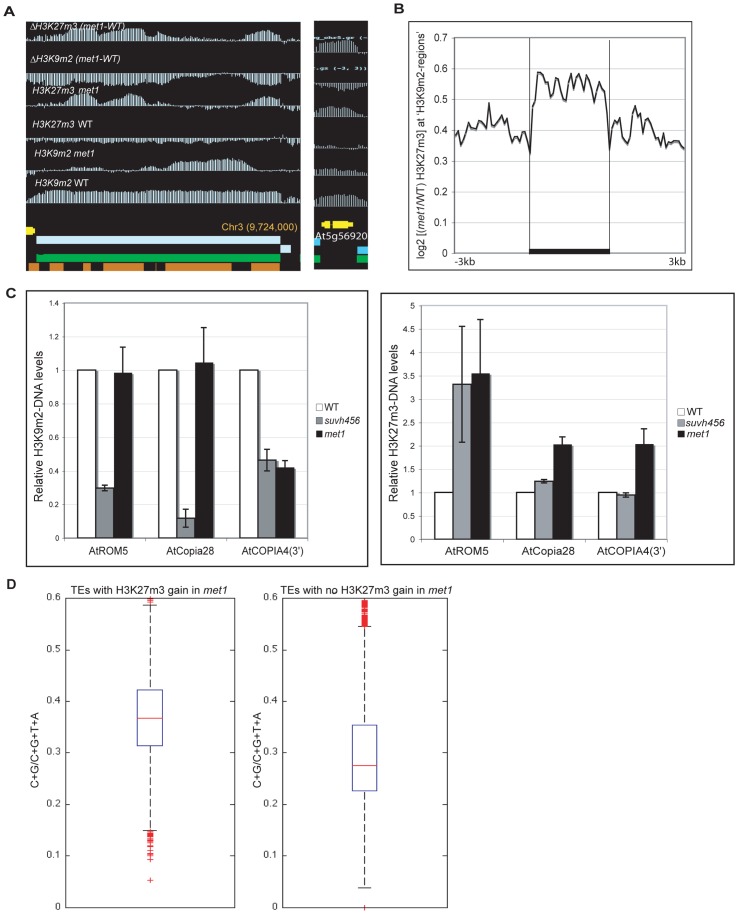
Ectopic gain of H3K27m3 at DNA hypomethylated regions.A. Genome-browser views of a transposable element on chromosome 3 (left) and of a heterochromatic gene, At5g56920 (right). B. Average distribution of the normalized H3K27m3 signals across H3K9m2 regions (horizontal black bars) in wild-type (defined in [9], perfectly correlate with transposons and methylated genes) C. Analysis of H3K9m2 and H3K27m3 marks at three transposons by ChIP followed by real-time PCR. Data were normalized to the input DNA and to an internal control (actin gene). D. C+G density of transposons that gain or do not gain H3K27m3 in met1. The red line represents the median; the edges of the box represents the 25th and 75th percentiles, the whiskers stretch out to 1.5× interquartile range above and below the edges of the box; the red dots represent the outliers. Two-tailed p-values were calculated by Wilcoxon ranksum test.